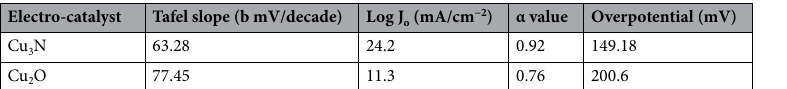
Electro-catalyst